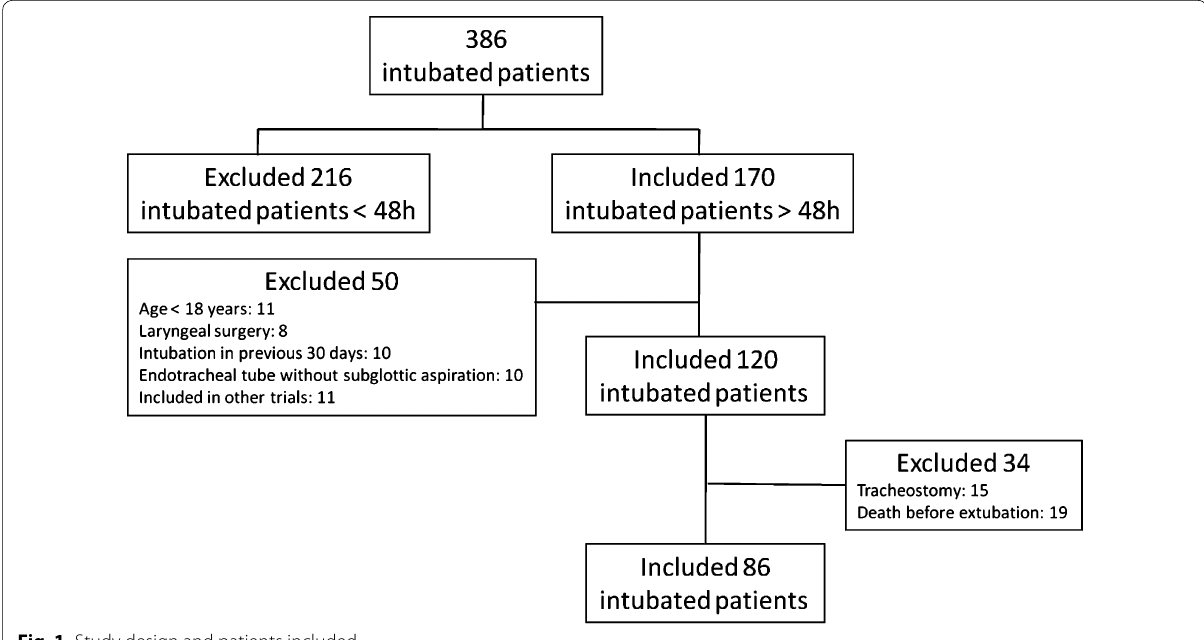
Fig. 1 Study design and patients